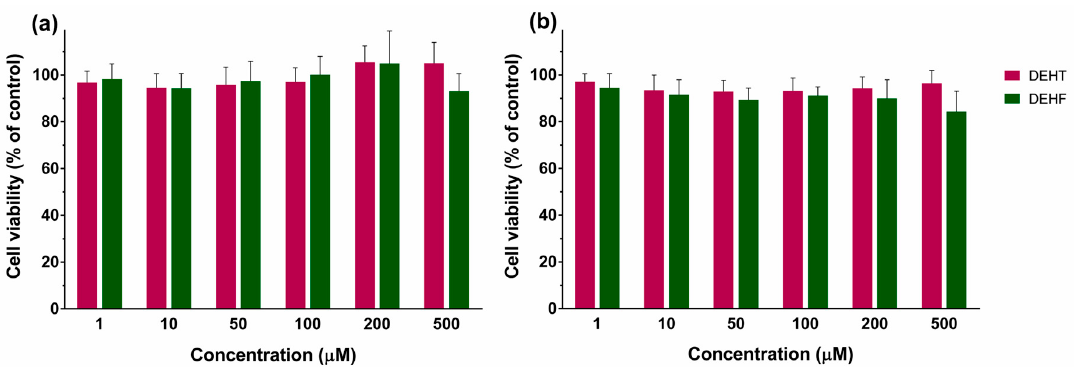
Figure 6. Cell viability in 3T3-L1 cell line after ( a ) 48 h and ( b ) 72 h of incubation in the presence of DEHF or DEHT plasticizers. Values represent the mean ± standard deviation (n = 9).